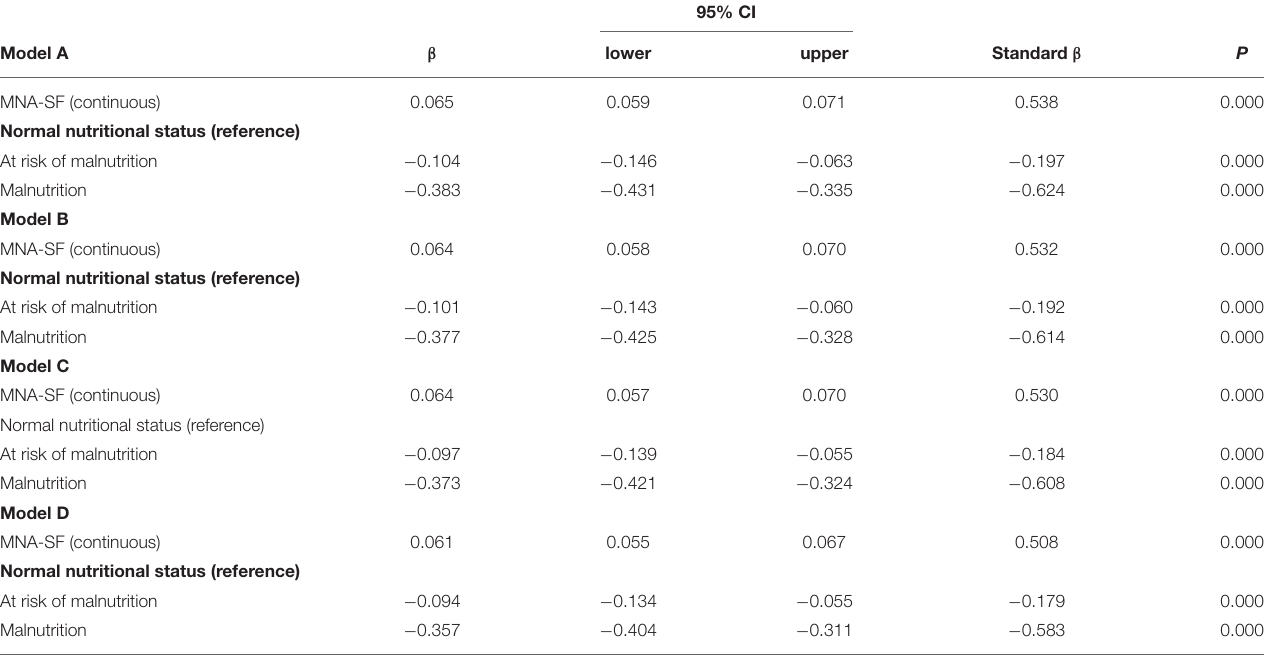
TABLE 2 | Association between nutritional status and quality of life (EQ-5D)